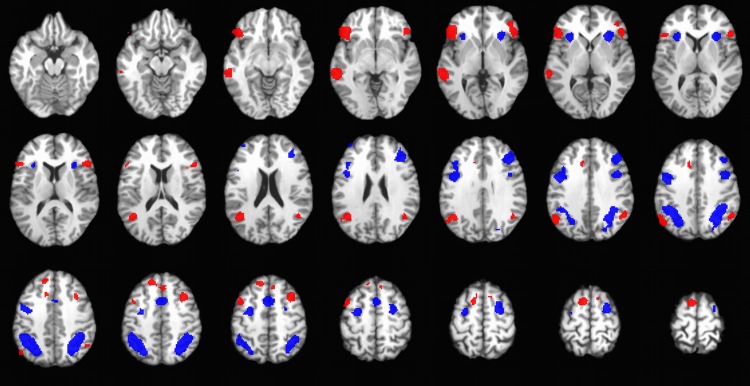
Mosaic view of the contrast "emotion regulation > working memory" (red) and "working memory > emotion regulation" (blue).Maps were thresholded at P < 0.05 and were superimposed on a T1-weighted structural image in axial sections from z = -8 mm to z = 61 mm, with a between-slice gap of 3 mm.